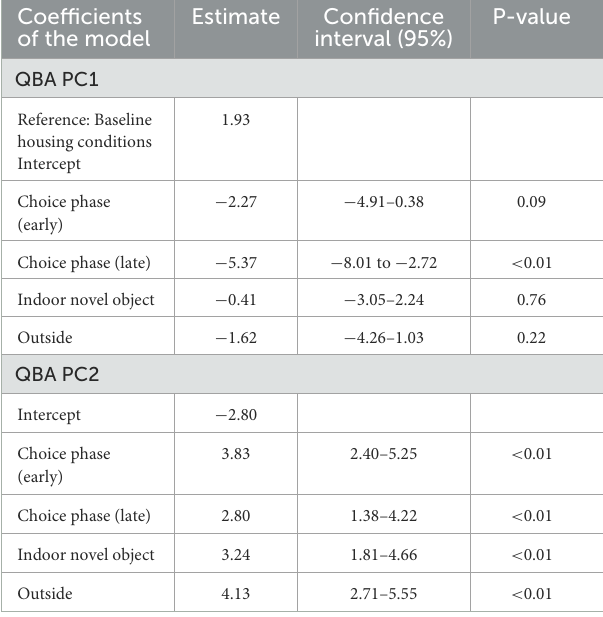
TABLE 4 Group 2: Results of the linear model assessing PC1 and PC2 scores attained during the different treatment periods. Coefficients Estimate Confidence of the model interval (95%)